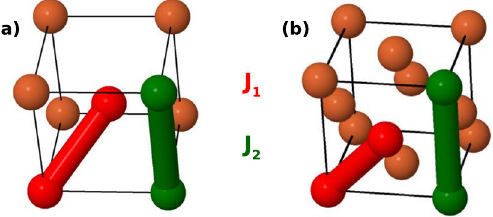
Figure 1. Schematic representation of the near neighbor (NN) and next-near neighbor (NNN) of a ( a ) bcc and ( b ) fcc lattice. In red the bond between NN and in green the bond between NNN.